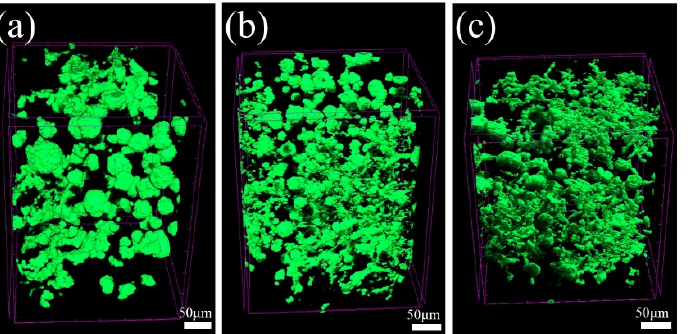
Figure 7. Two-dimensional morphology of graphite in ( a ) specimen 1, ( b ) specimen 2 and ( c ) specimen 3 [43].